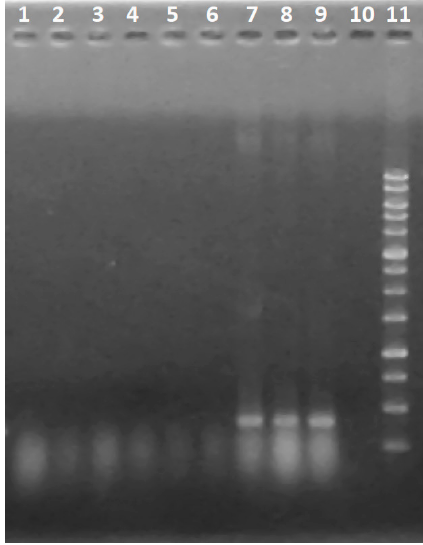
Figure 9. Amplification of tex1 by PCR from Fusarium moniliforme SZMC 11046 (1), 2. Fusarium culmorum SZMC 6239J (2), Fusarium graminearum SZMC 6236J (3), FOSC SZMC 6237J (4), Alternaria solani SZMC 6241J (5), Rhizoctonia solani SZMC 21048 (6) Trichoderma asperellum IRAN 3062C (7) T. asperellum BS3-8 [50] (8), Trichoderma longibrachiatum IRAN 3067C (9), and H 2 O as negative control (10). Molecular weight marker: 100 bp ladder (11).